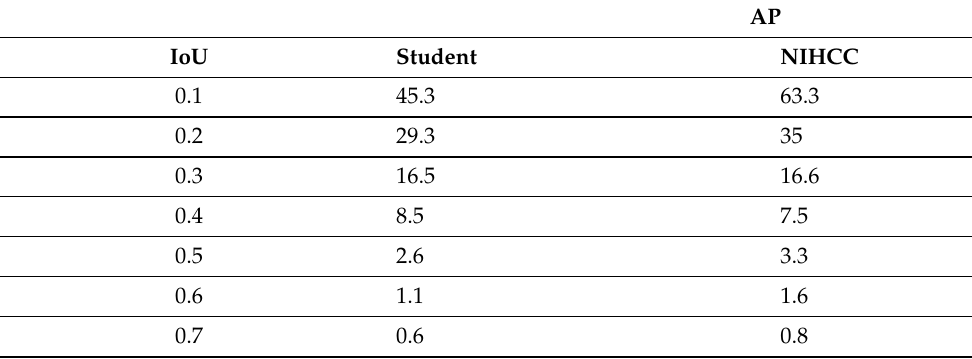
Table 9. Comparison of pneumonia detection performance between the student and NIHCC